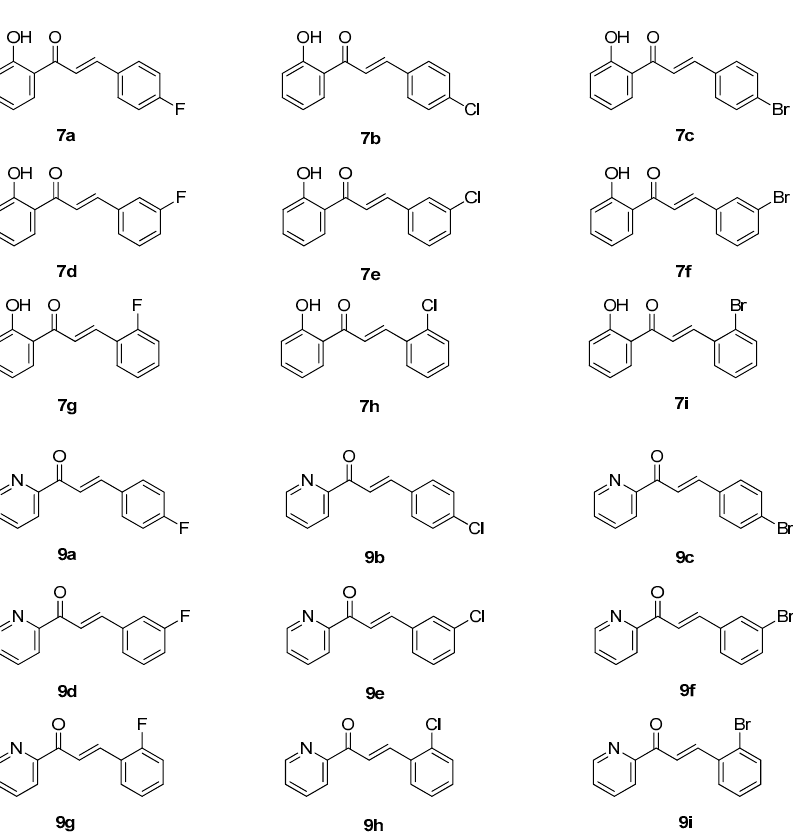
Figure 4. Conditions of synthesis of azachalcones 9a – i .